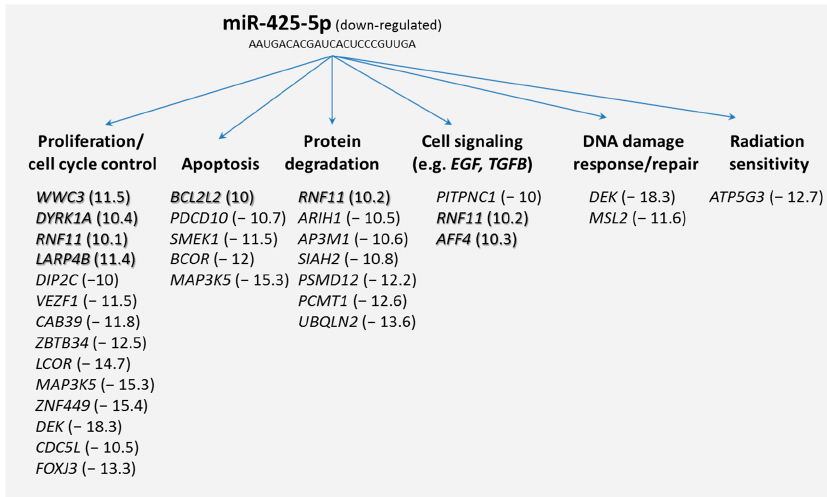
Figure 3. Potential target genes of miR-425-5p that were >two-fold up (shadowed) or downregulated between the HARS groups were grouped according to their coding function using their gene ontology data (The National Center for Biotechnology Information (NCBI) data base). Fold changes are given in parentheses.